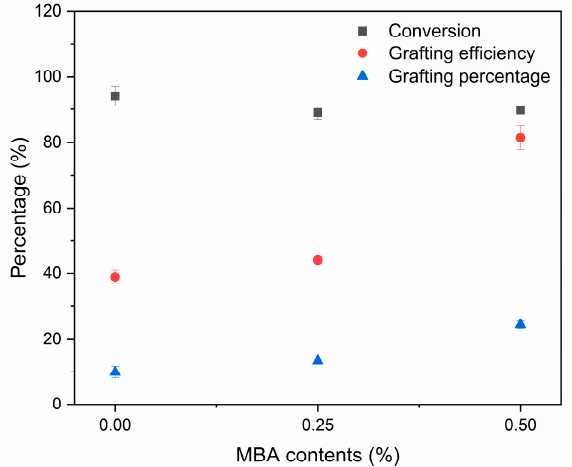
Figure 1. Effect of crosslinking agent contents on the monomer conversion, grafting efficiency and Figure 1. E ff ect of crosslinking agent contents on the monomer conversion, grafting e ffi ciency and grafting grafting percentage.